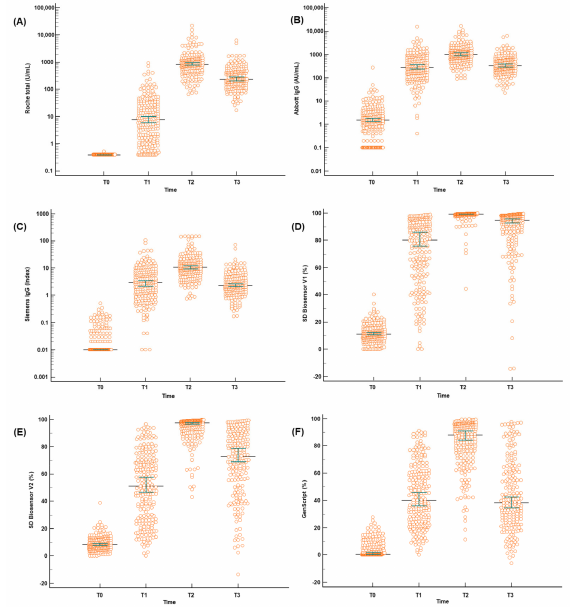
Figure 1. Quantitative serological response after a ChAdOx1 nCoV-19 vaccination: ( A ) Roche total antibody; ( B ) Abbott IgG; ( C ) Siemens IgG; ( D ) SD Biosensor V1 neutralizing antibody; ( E ) SD Biosensor V2 neutralizing antibody; and ( F ) GenScript neutralizing antibody. Antibody titers from T0 (before injection), T1 (1 month), T2 (4 months), and T3 (7 months) are illustrated. The differences between T2 and T3 of all the included assays were significant ( p < 0.001). p -values were calculated using the Steel-Dwass-Critchlow-Finger test for quantitative differences. A logarithmic scale was applied to the y axes of the plots for Roche total, Abbott IgG, and Siemens IgG. Table 3. Agreement rates between the five SARS-CoV-2 assays 1